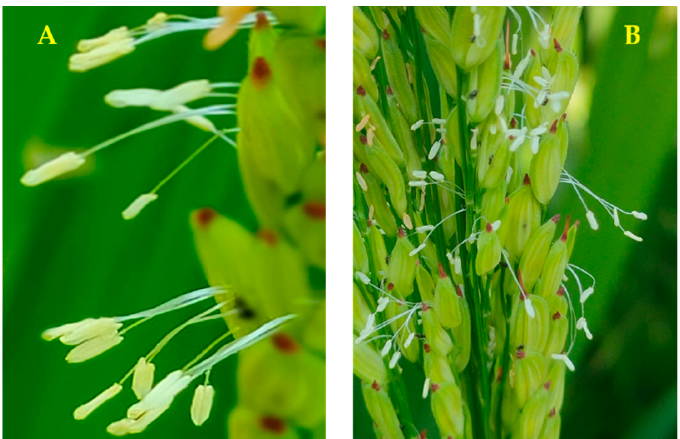
Figure 4. ( A ) picture of the flowers of one of the newly developed lines showing the flowering and ( B ) picture of the flowers of one of the newly developed breeds, showing the length of anthers, filament, and size of the